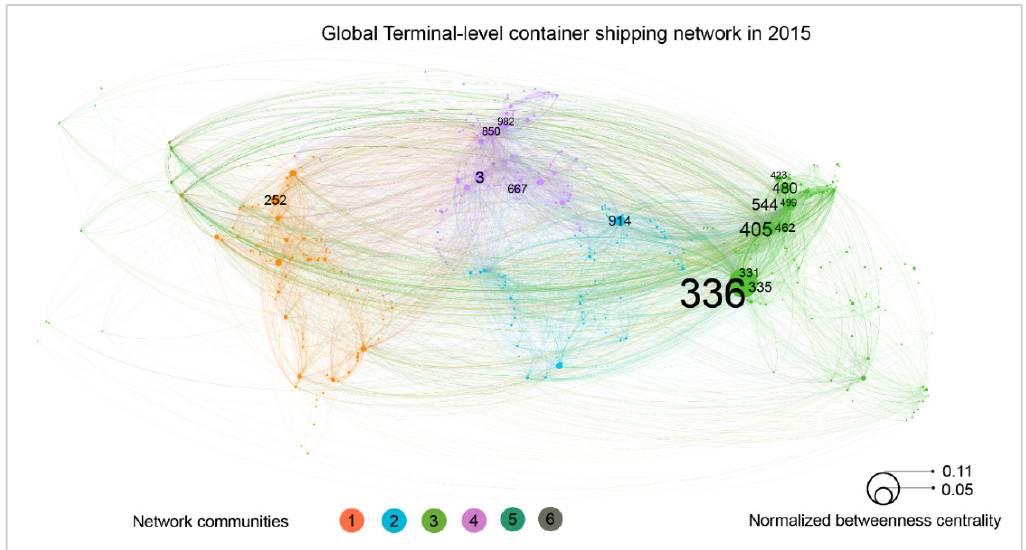
Figure 10. Terminal level GCSN extracted from ship AIS data in 2015. A directed and weighted network with 14,060 links and 754 container terminal nodes located in 513 ports. The size of a node refers the normalized betweenness centrality of a given node. The color refers to the six community clusters of the network. The color of a link is equal to the color of its departure node. The width of a link is equal to a rescaled link weight. The label of each node is the global terminal ID produced by this study.